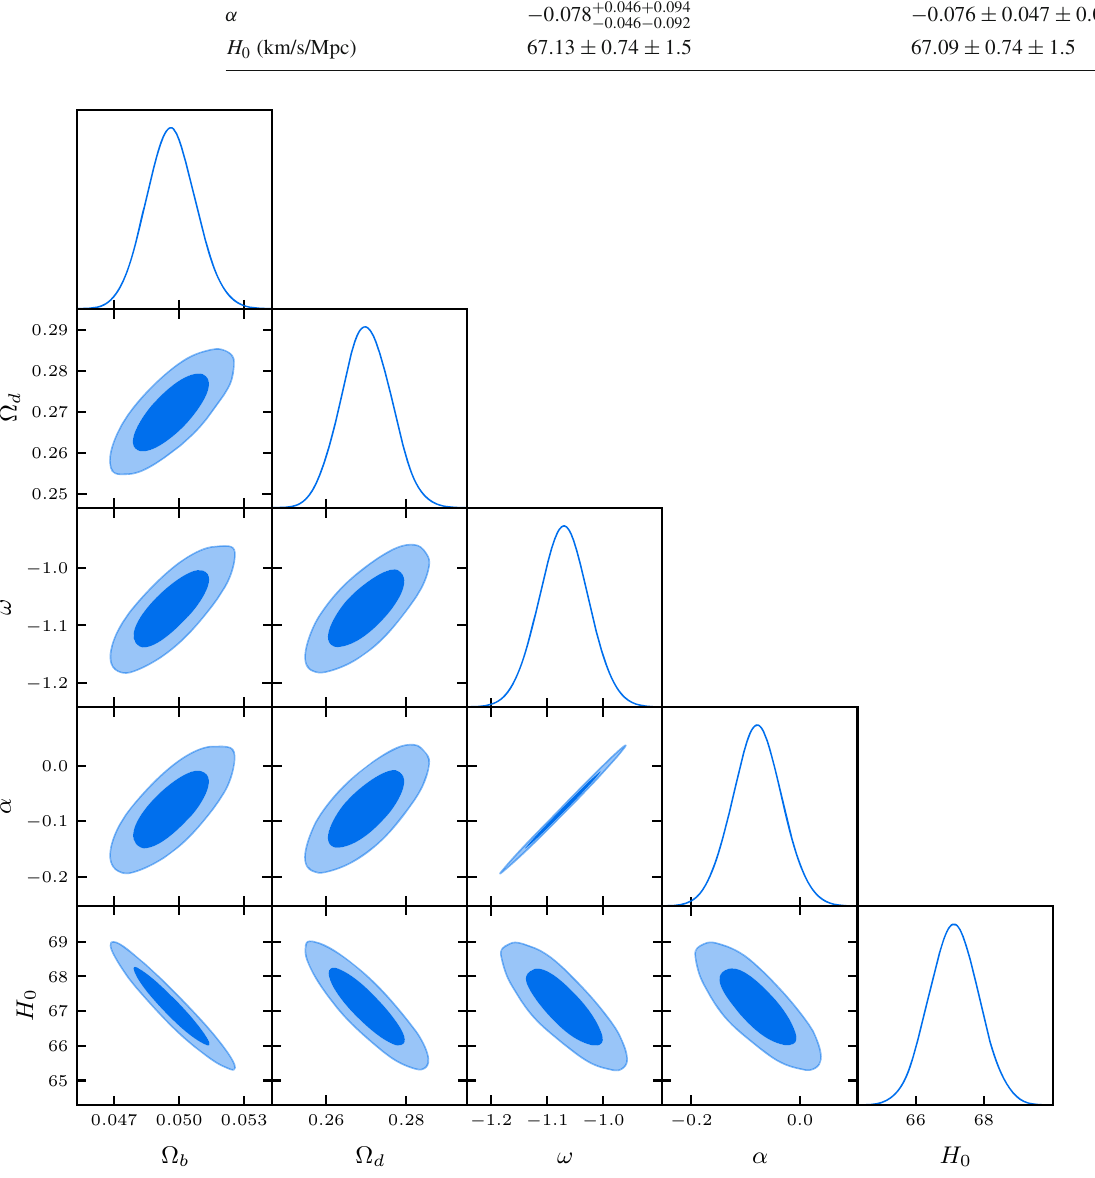
Fig. 5 Combined constraints from Pantheon+ H ( z ) +Planck18 ( (cid:4) CDM prior)+BAO on DM-DE interacting model with w (cid:4)= − 1